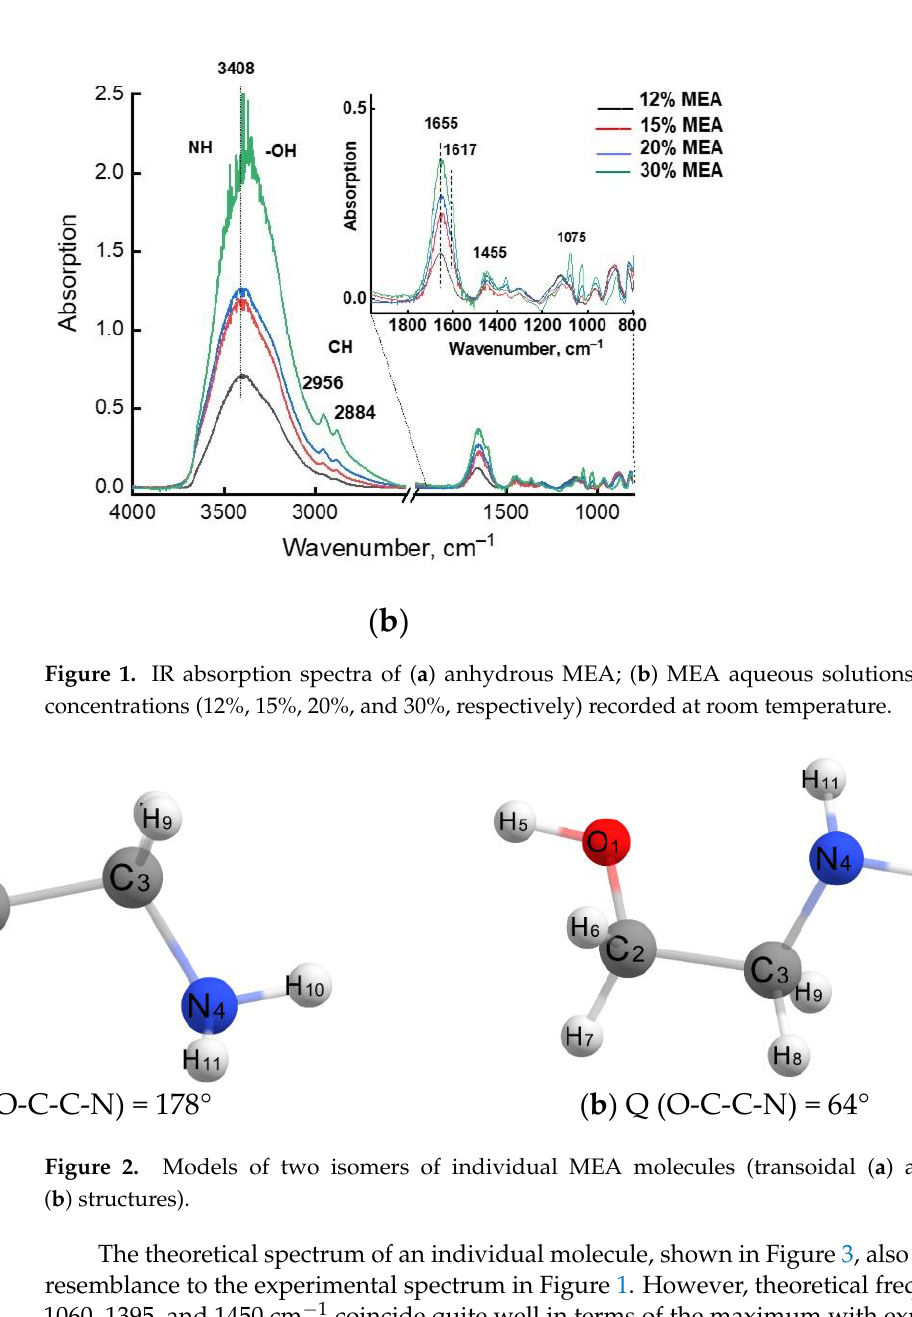
Figure 2. Models of two isomers of individual MEA molecules (transoidal ( a ) and gauche ( b ) structures).